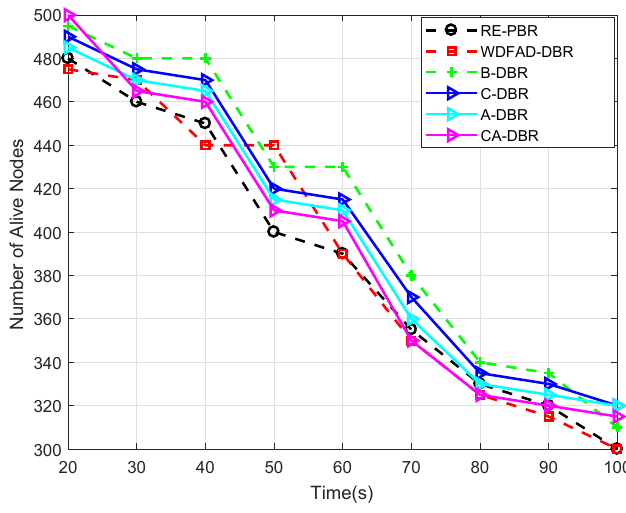
Figure 11. Comparison of alive